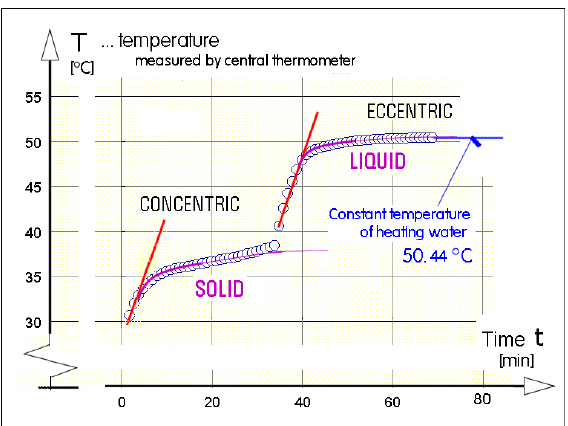
Fig. 19. Time dependence of the temperature T 101 measured by the resistor thermometer probe initially positioned in the centre of the n -eicosane solid body, at the tip of the vertical